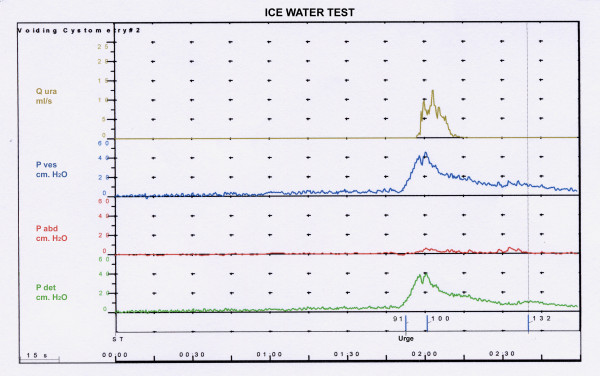
Positive IWT in NDO patient. Representative cystometrogram of a NDO patient showing a positive IWT associated with urgency and fluid expulsion at 88 mls filling with cold saline.